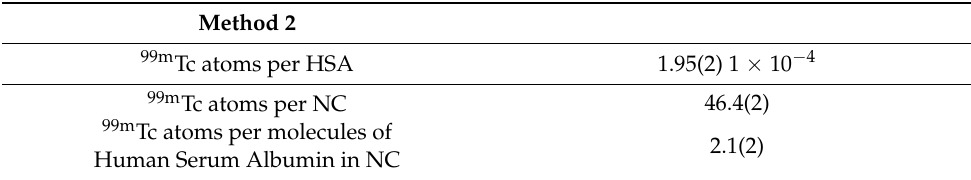
Table 7. 99m Tc tightly bound to HSA, NC and then normalised to the Human Serum Albumin that form NC. Mean